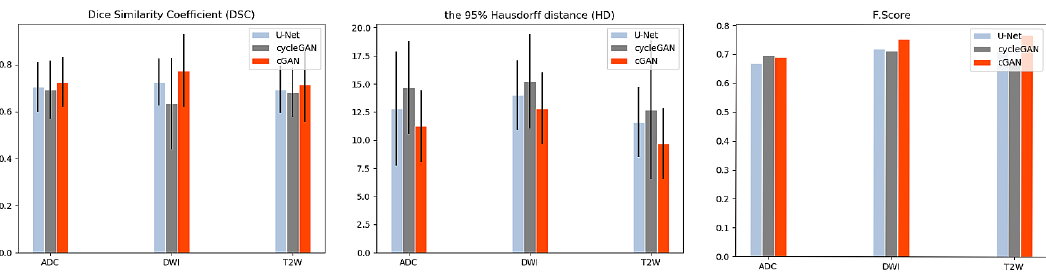
Figure 4. The mean and standard deviation values computed for the Dice Similarity Coefficient (DSC), Hausdorff distance (HD) and F.Score metrics using U-Net, cycleGAN and cGAN models, regarded as “base-models". Base models are trained only on the raw data. X-axis represents the MRI modality; y-axis represents the mean value and vertical black line represents the standard deviation.